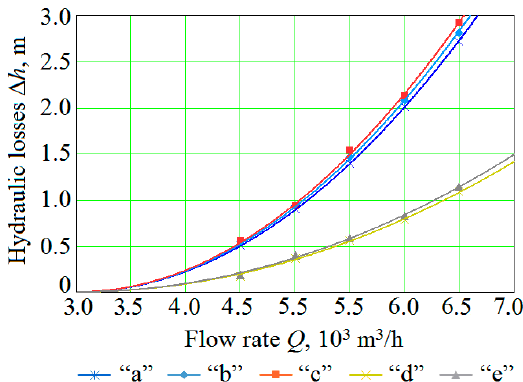
Figure 8. The dependence of the hydraulic losses on the flow rate for the different design models of the air distribution system.